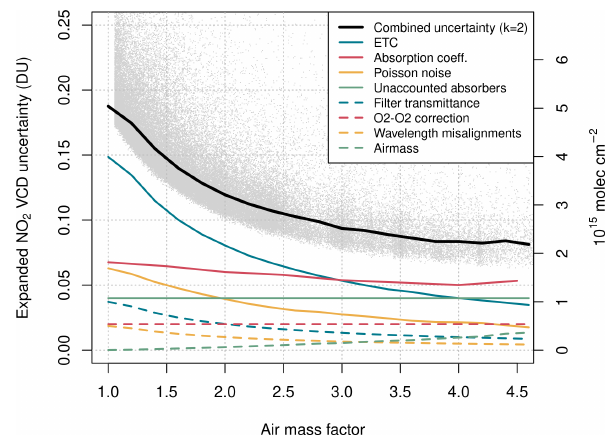
Figure 5. Total expanded uncertainty (black line) and its compo- nents, discussed in the text. The lines represent the median values for each air mass bin. Uncertainties are actually estimated for each individual measurement, here represented as grey